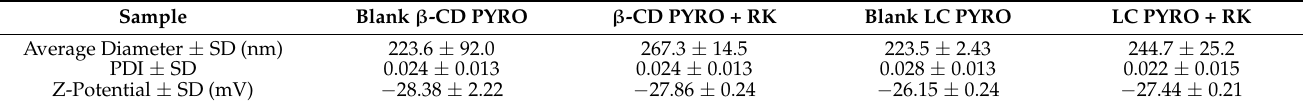
Table 1. Physicochemical characterization of blank and RK-loaded NSs. Table 2. Physicochemical characterization of blank and RK-loaded NSs after 1 month stored at 4 ◦